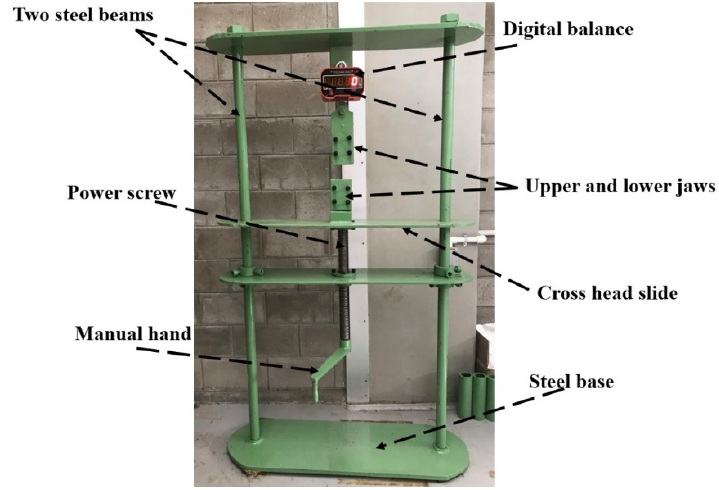
Figure 6. Manual relaxation testing device.